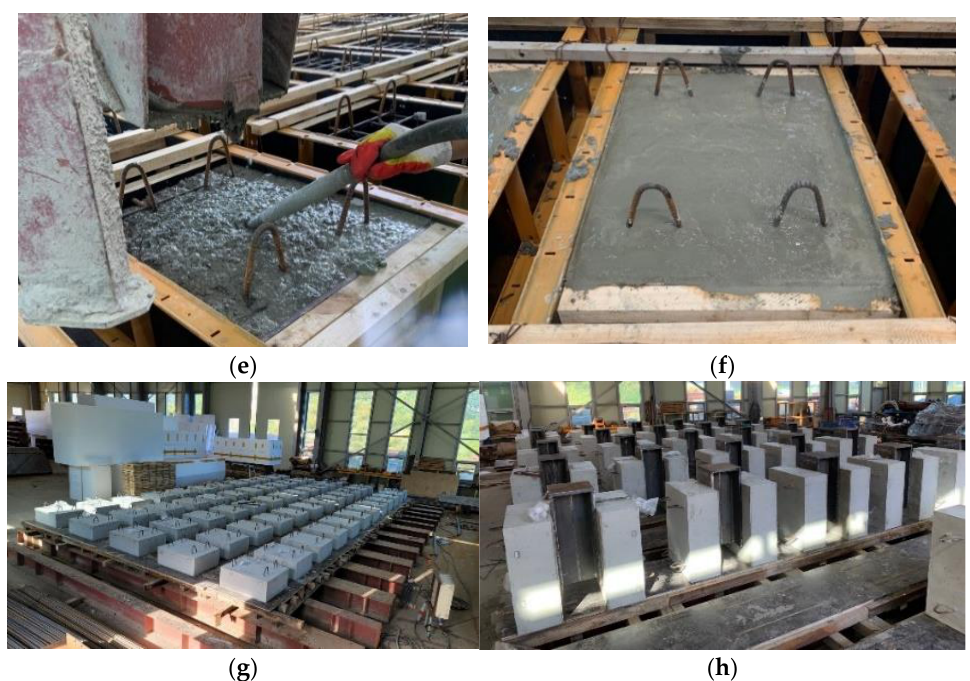
Figure 2. Fabrication process of specimens. ( a ) Rebar mesh, ( b ) formwork, ( c ) styrofoam installa- tion, ( d ) spreading grease, ( e ) concrete pouring, ( f ) concrete compaction, ( g ) removal of forms and ( h ) specimen completed. Table 2. Concrete compressive strength (unit: MPa).